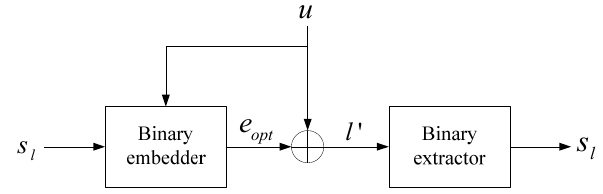
Figure 1. Block diagram of a binary embedding system.